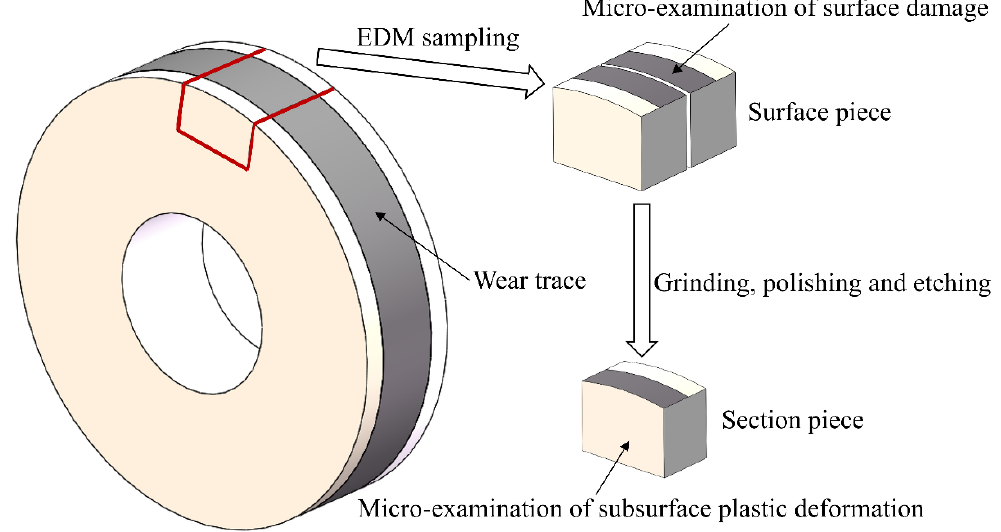
Figure 6. Sampling preparation of circumferential surface and section of the wheel / rail discs after the rolling-sliding test.